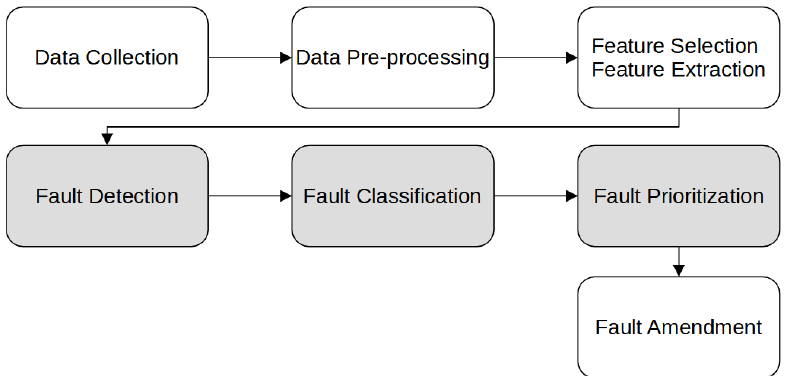
Figure 1. The overall fault handling process begins with the data collection, including pre-processing of the data and feature handling before training models for fault detection and fault classification. Afterwards, fault prioritization occurs; after that, all found faults will be handled manually by the operators’ personnel or automatically during the fault amendment process. Due to the individuality nature of the steps or their maturity, not all research fields are covered by this survey. Investigated research fields are covered by grey boxes, whereas white boxes cover the